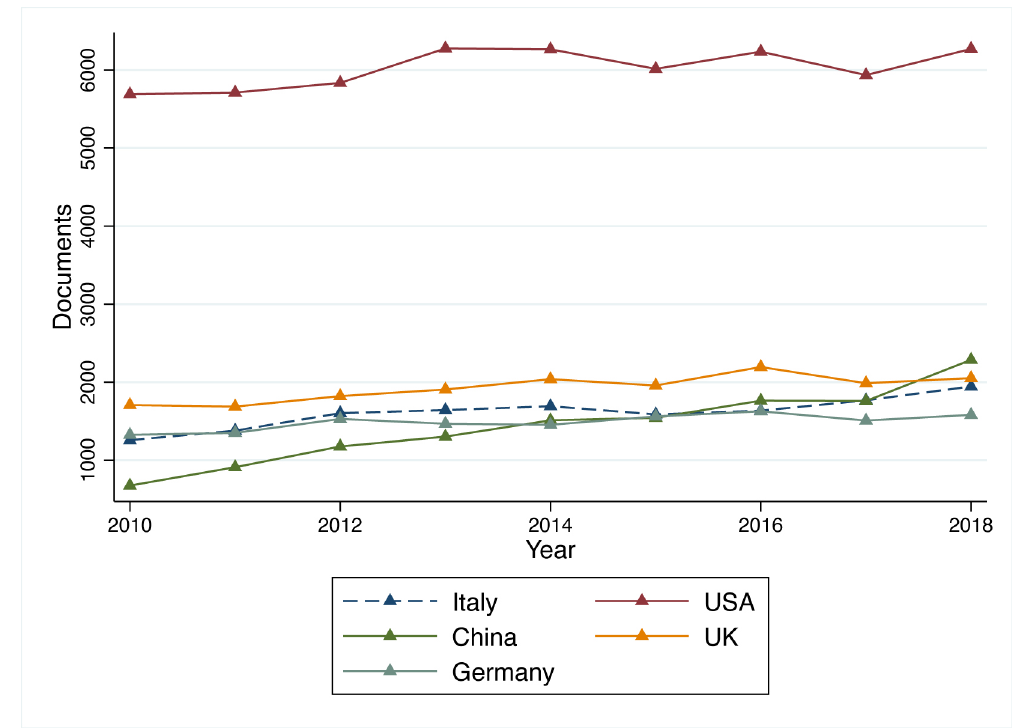
Figure 2. Trends in the outputs of endocrinology and diabetes research papers, between 2010 and 2018, for the top five